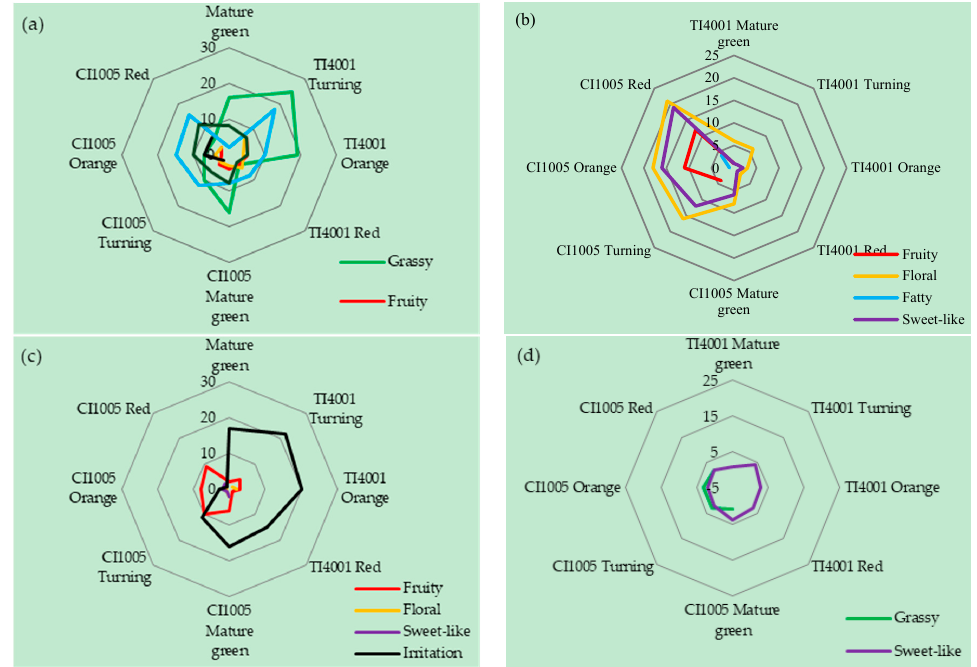
Figure 2. Contribution of volatiles derived from different metabolic pathways to the aromas of tomato fruits: ( a ) fatty acid-derived, ( b ) carotenoid-derived, ( c ) phenylpropane-derived, and ( d ) BCAA-derived.